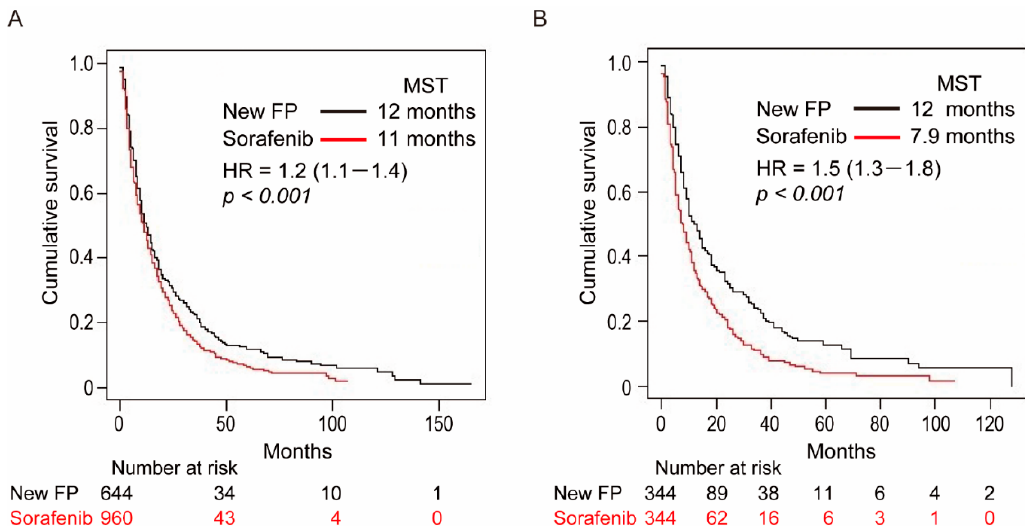
Figure 3. Overall survival curves of patients in the New-FP and sorafenib groups. ( A ) New-FP ( n = 644, black line) and sorafenib ( n = 980, red line) before propensity score matching, p < 0.001. ( B ) New-FP ( n = 344, black line) and sorafenib ( n = 344, red line) after propensity score matching, p < 0.001. Abbreviations: MST, median survival time; HR, hazard ratio.